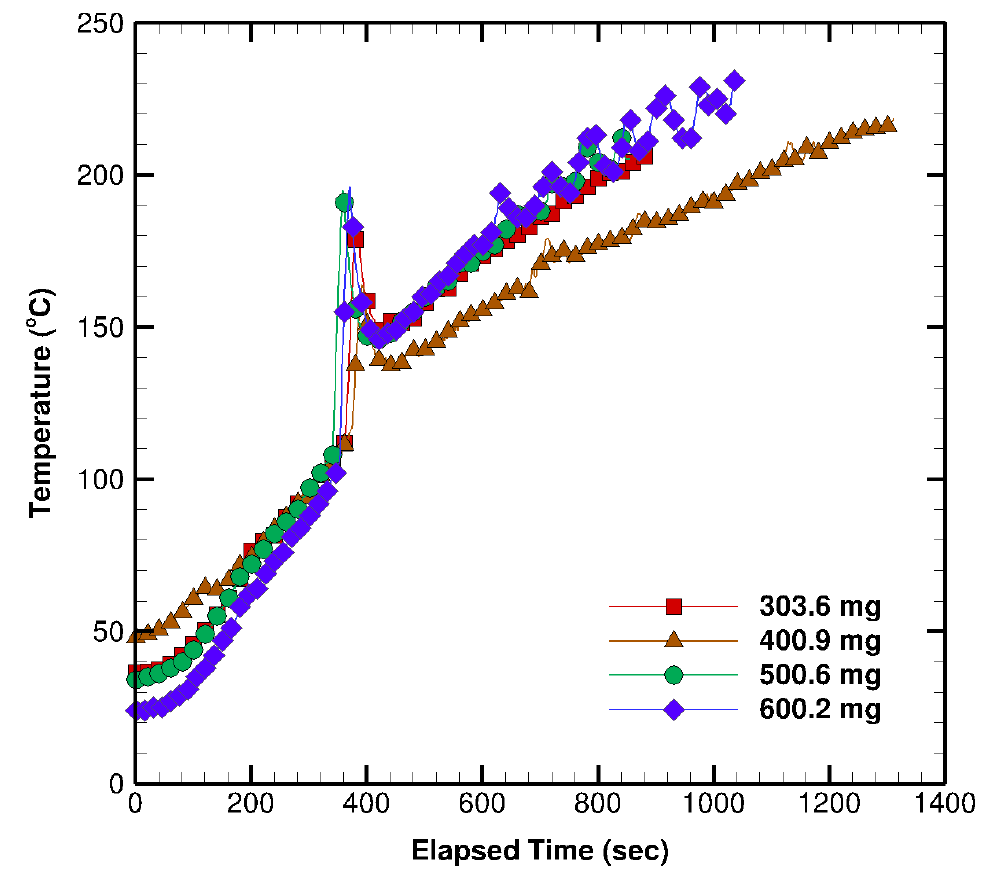
Figure 6. Temperature histories for pressure vessel experiments for different masses of the CBA. The onset of the decomposition of the CBA at the activation temperature is accompanied by a sudden increase in temperature and pressure. It is seen that the temperature histories are mostly insensitive to the initial CBA mass, as would be